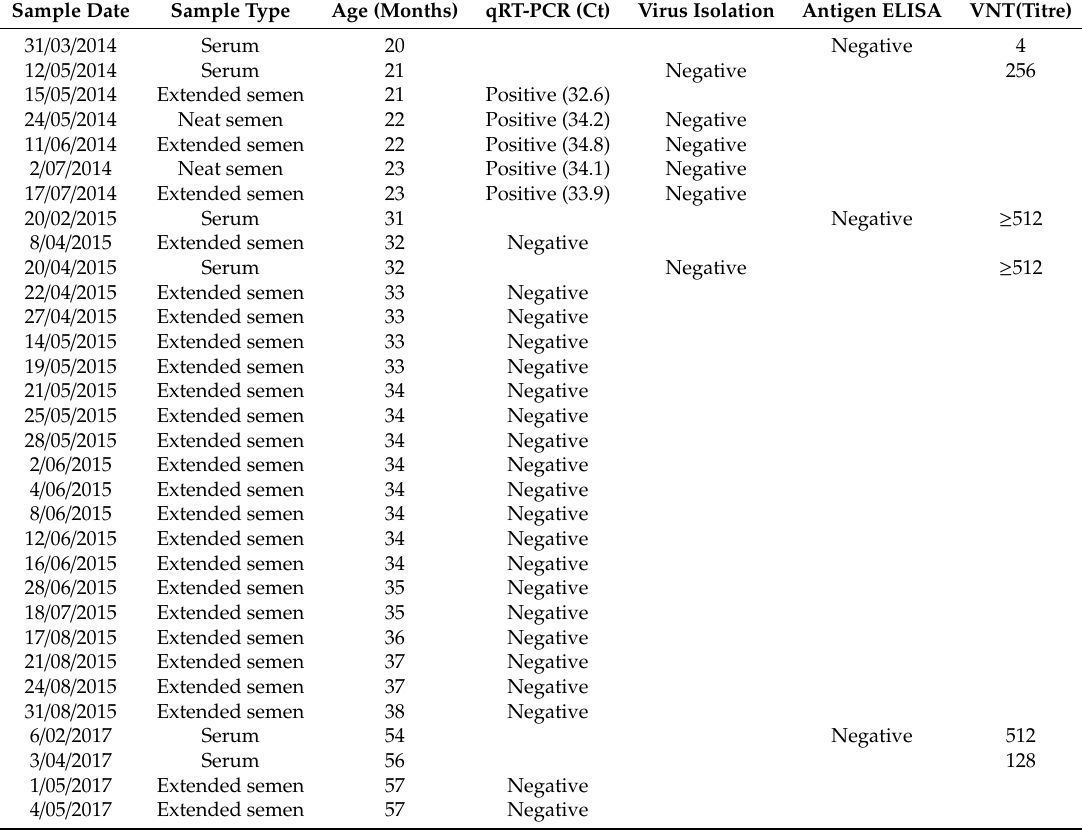
Table A5. Serological and virological test results for Bull 5.